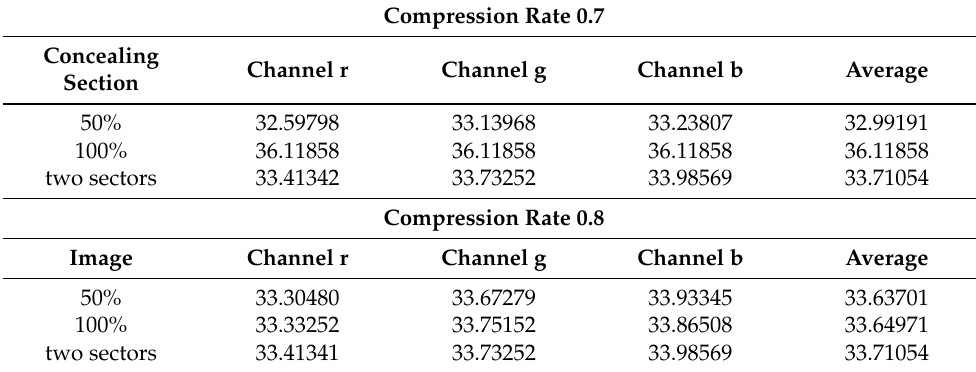
Figure 4. The concealed sections in the first and second rows are 50% and 100%, respectively, and the last row shows the results of concealing two independent sections of the original image. The first column contains the original image, the second and third columns show the reconstruction results of restricted-authorized receivers and full-authorized receivers under compression rate 0.7. The fourth and fifth columns show the reconstruction results under compression rate 0.8. Table 2. PSNR values for various concealing sections (Unit: